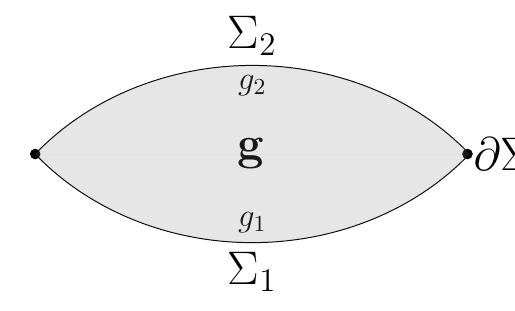
Σ 1 (b) The shaded region represents the gravitational path integral over the space-filling manifolds whose only boundary is Σ 1 ∪ Σ 2 . The bulk metric g satisfies Dirichlet boundary condition (i.e. g | Σ = 1 g 1 and g | Σ = g 2 ) . 2